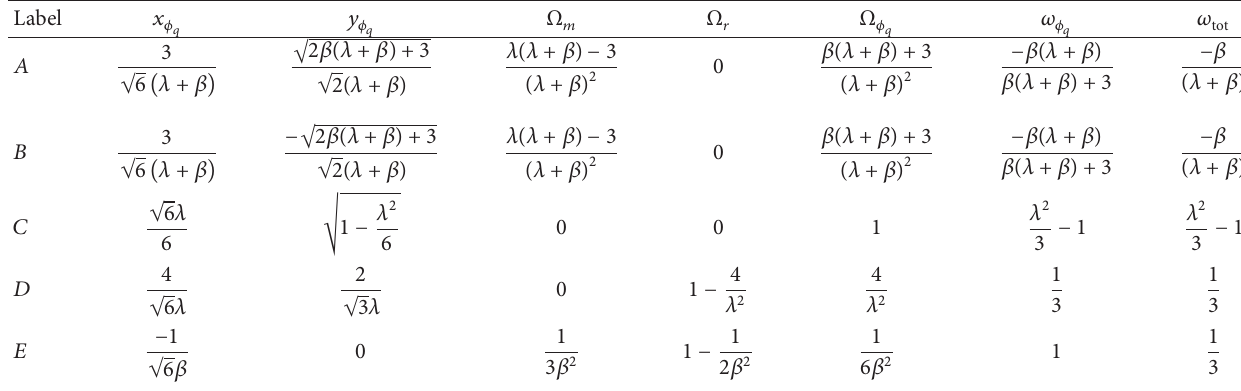
Table 1: Critical points and existence